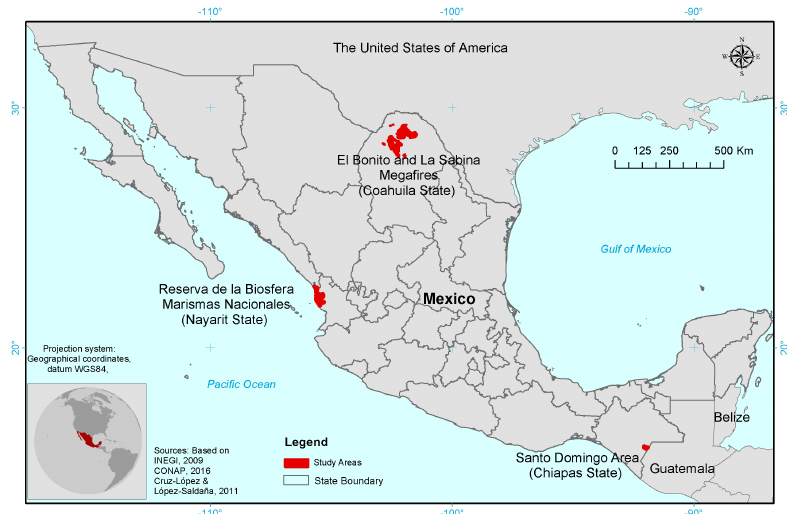
Figure 6. Study sites considered in this paper: El Bonito and La Sabina, Marismas Nacionales and Santo